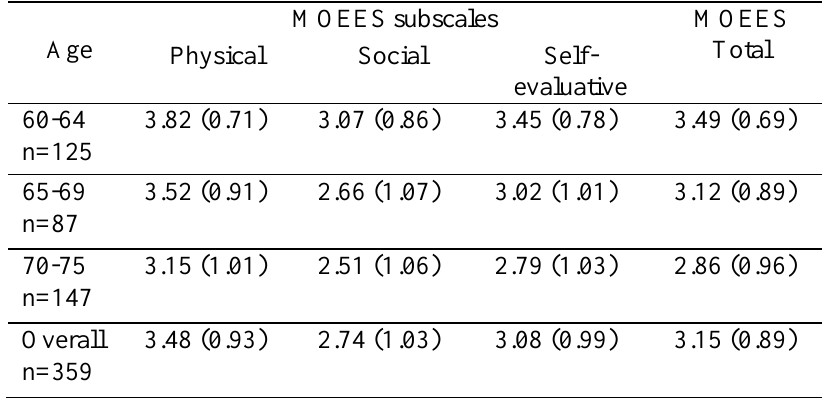
Table 3. Mean (standard deviation) values for Multidimensional Outcome Expectations for Exercise Scale (MOEES) in different age